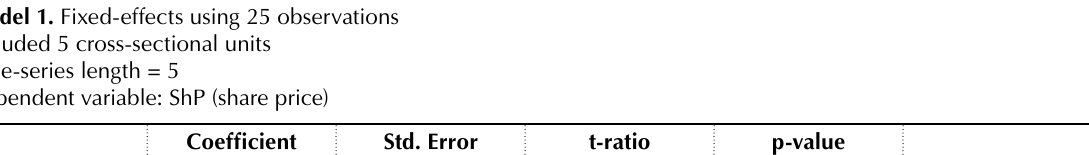
Table 1. Link between corporate social investment (CSI) and share price (ShP) of those companies